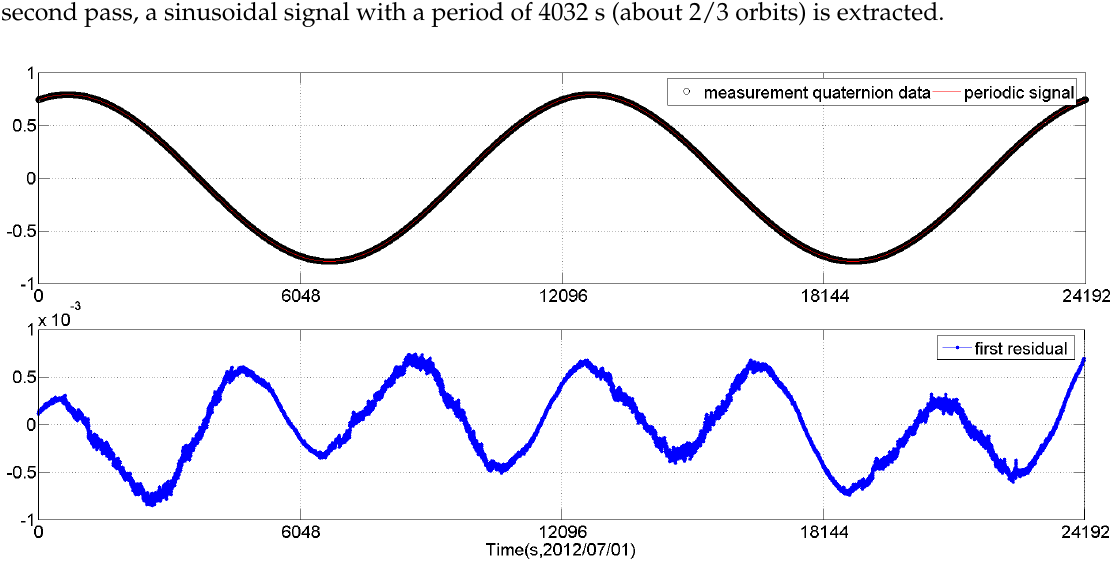
Figure 1. The first pass periodic signal extraction results of q 0 element of CCD01 quaternion data (a sinusoidal signal with a period of 12,096 s is extracted).